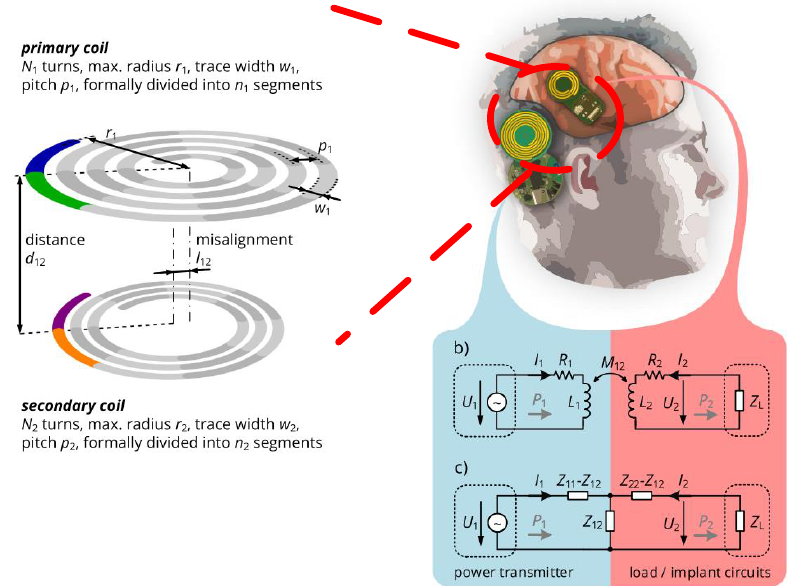
Figure 18. Geometrical coil optimization used for brain neural implant